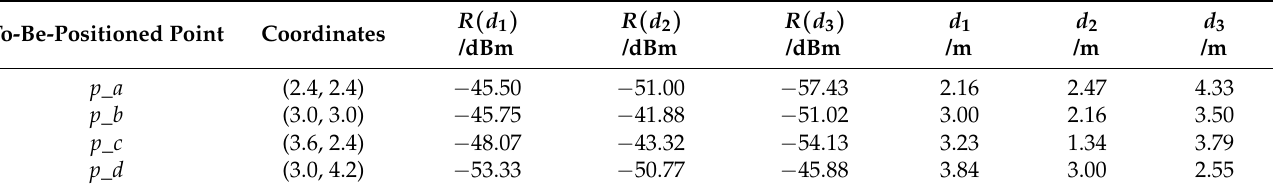
Table 2. Measured data of to-be-positioned